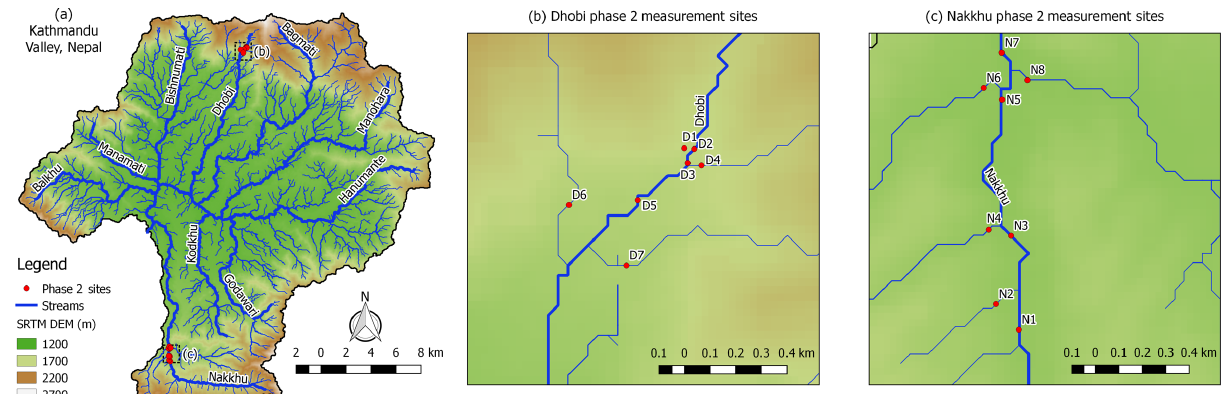
Figure 3. Map showing topography of the Kathmandu Valley, stream network, and locations of phase 2 measurement sites (a) . Names of the 10 historically perennial tributaries are shown. (b) shows an enlarged view of the upper Dhobi watershed where phase 2 measurements D1 through D7 were performed. (c) shows an enlarged view of the middle Nakkhu watershed where phase 2 measurements N1 through N8 were performed. Measurement sites are labeled with phase 2 site